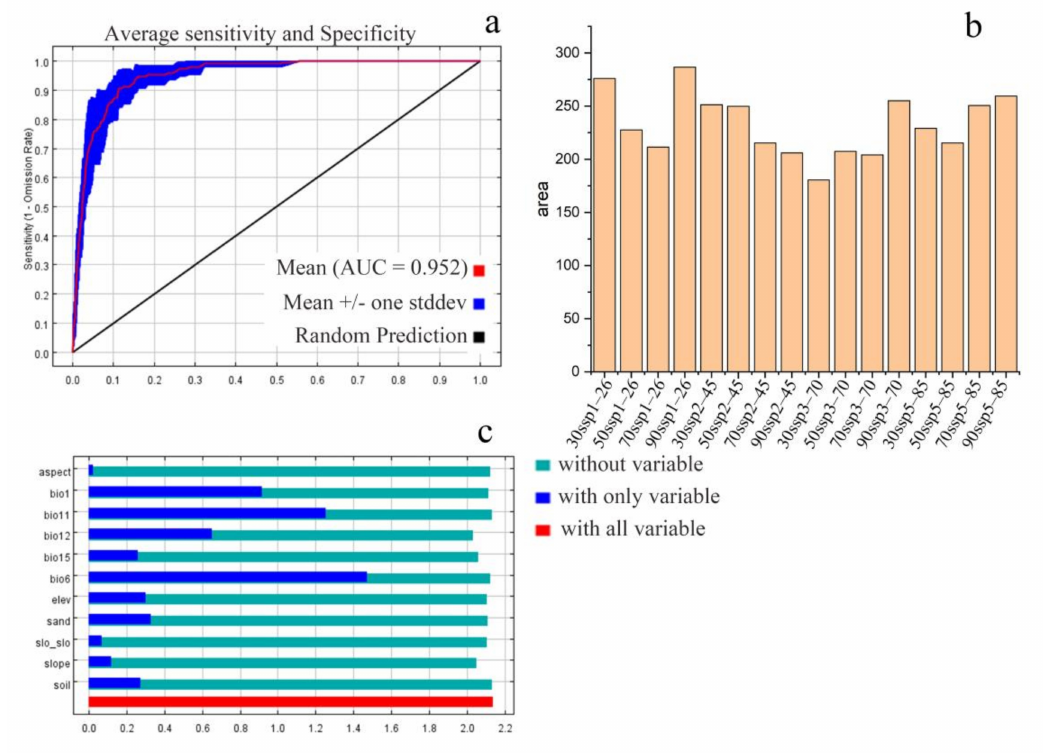
Figure A1. The receiver operating characteristic curve ( a ), area of suitable habitats of Valsa mali in di ff erent climate scenarios ( b ), and the Jackknife test of environmental variables ( c